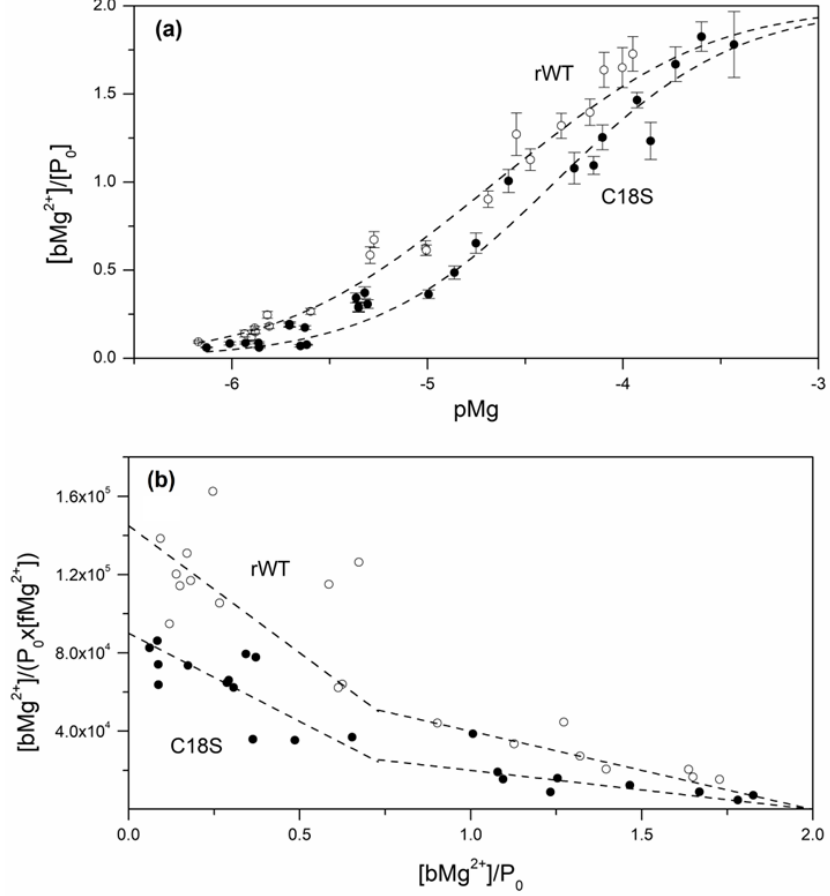
Figure 5. Determination of Mg 2+ affinity of rWT/C18S Ocm at 20 °C by equilibrium dialysis. Ocm concentration was 50–200 μM. Buffer conditions: 30 mM HEPES-KOH, 1 mM EGTA, pH 7.4 and 2–750 μM Mg(NO 3 ) 2 . [bMg 2+ ], concentration of Mg 2+ bound to Ocm; [fMg 2+ ], free Mg 2+ concentration; P 0 , total Ocm concentration. ( a ) Dependence of the number of Mg 2+ ions bound per Ocm molecule upon pMg. The points are experimental, dashed curves are theoretical computed according to the sequential metal binding scheme [IV] using Equation (5) (see Table 4). ( b ) Scatchard plot.